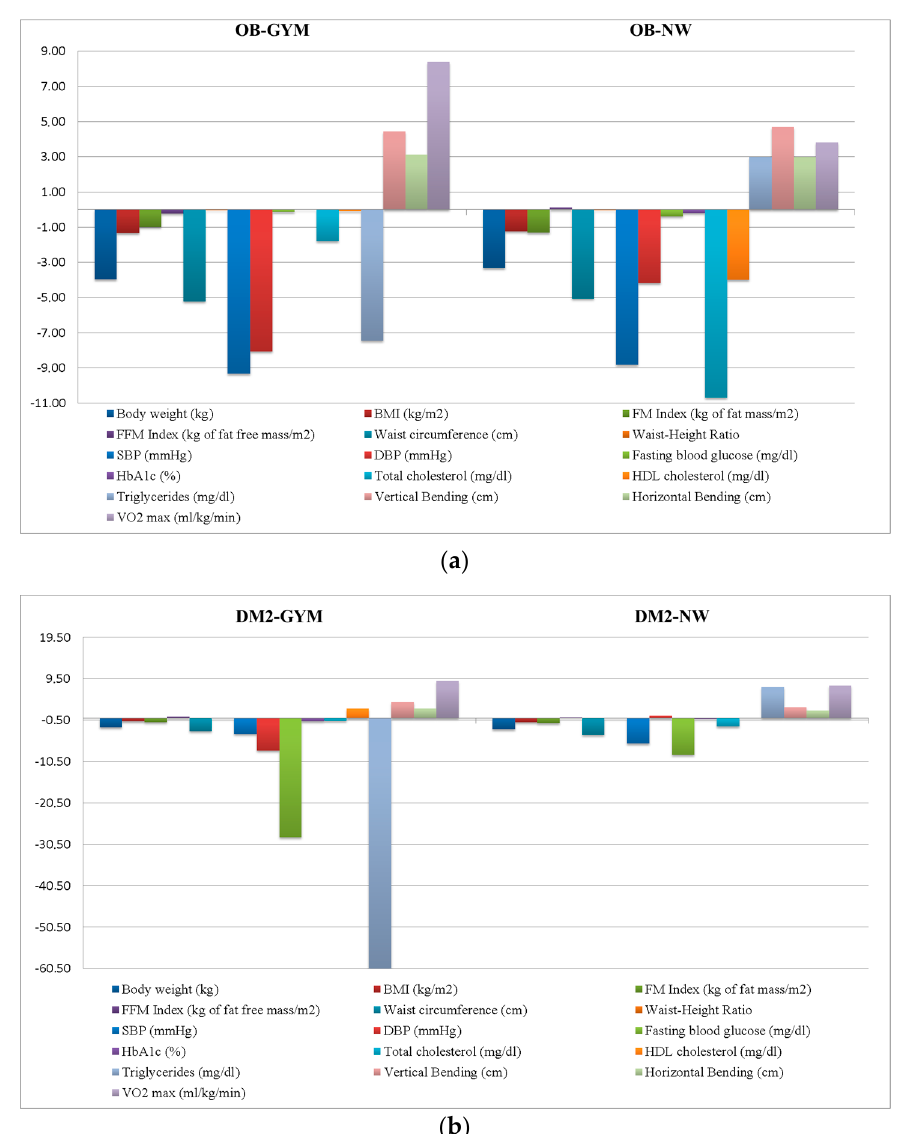
Figure 2. ( a ) Anthropometric profile, blood pressure levels, blood chemistry and fitness parameters in obese people. Results are presented as Δ (T1-T0) means. ( b ) Anthropometric profile, blood pressure levels, blood chemistry and fitness parameters in people with type 2 diabetes. Results are presented as Δ (T1-T0) means. Abbreviations: OB-GYM : individuals with obesity participating at gym-based exercise program; OB-NW : individuals with obesity participating at the Nordic walking exercise program; DM2-GYM : obese individuals with DM2 participating at the gym-based exercise program; DM2-NW : obese individuals with DM2 participating at the Nordic walking program.